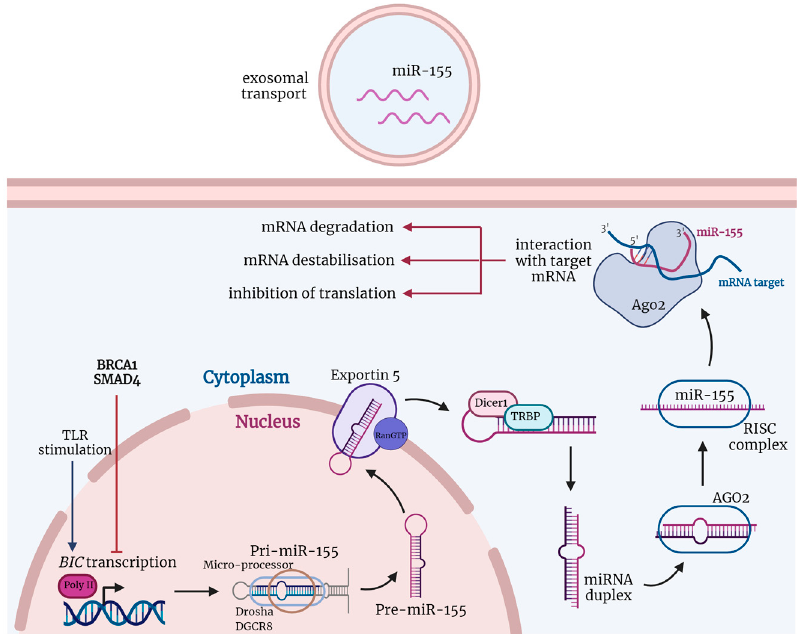
Figure 1. The biogenesis and function of miRNAs are shown via the example of miR-155. The non- coding B cell integration cluster ( BIC ), which encodes miR-155, is transcribed by polymerase II (poly II) into a double-stranded primary RNA transcript (pri-miR-155) after stimuli, such as stimulation of toll-like receptors (TLRs). Pri-miR-155 is cleaved by the ribonuclease—DROSHA and its cofactor binding protein, DGCR8—into precursor miRNA (pre-miR-155). Pre-miR-155 is transported by the GTP-dependent Exportin 5 from the nucleus to the cytoplasm, where the ribonuclease Dicer1 processes it into mature but still double-stranded miR-155. After this, miR-155 and argonaut 2 (AGO2), together with other proteins, create an RNA-induced silencing complex (RISC). RISC unwinds the double-stranded miR-155, and one of its strands is degraded while the second remains and acts as a sequence-specific guide for proteins. MiR-155 in the RISC complex promotes target mRNA degradation and destabilization or inhibits its translation. Created with BioRender.com (agreement number: DV24GT9WQS, accessed on 30 September 2022).